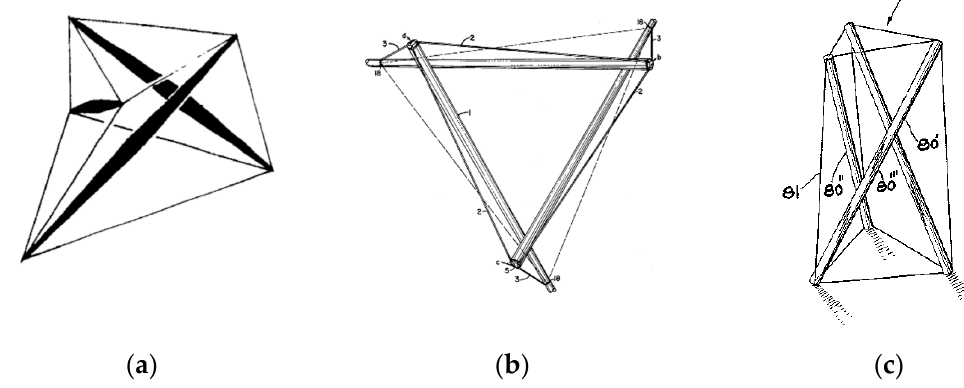
Figure 1. Patents of Simplex modules: ( a ) Emmerich’s [6], ( b ) Fuller’s [7], ( c ) Snelson’s [8].